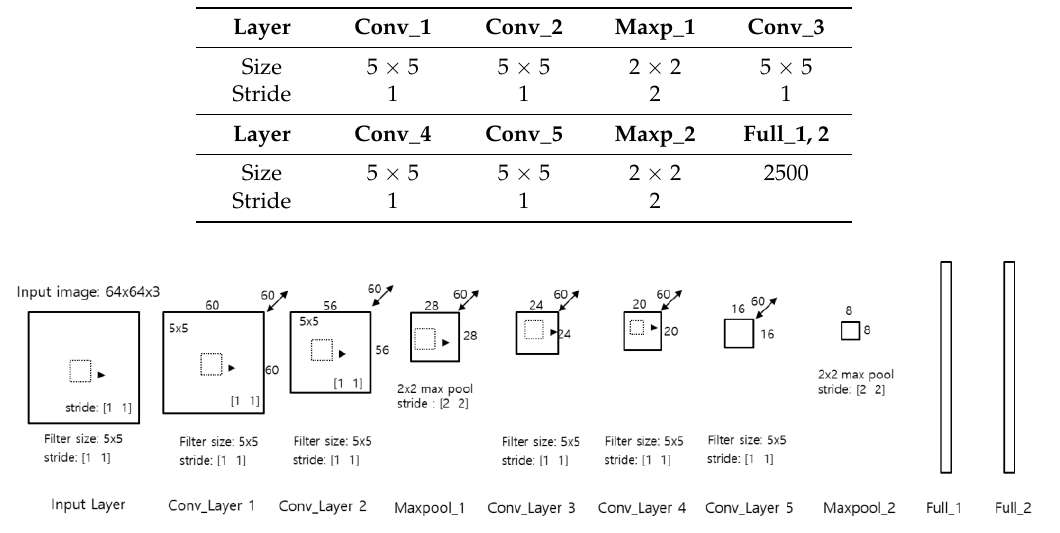
Table 1. Proposed convolution neural network (CNN) model parameters.